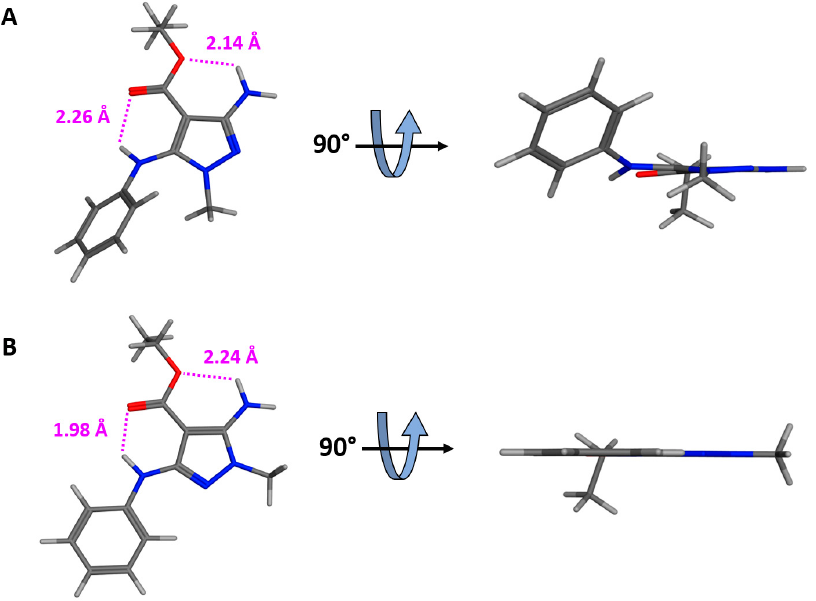
Figure 2. Low energy conformers of 8a (panel ( A )) and 8b (panel ( B )). The intramolecular hydrogen bonds are represented as purple dotted lines. The O-H distances are also